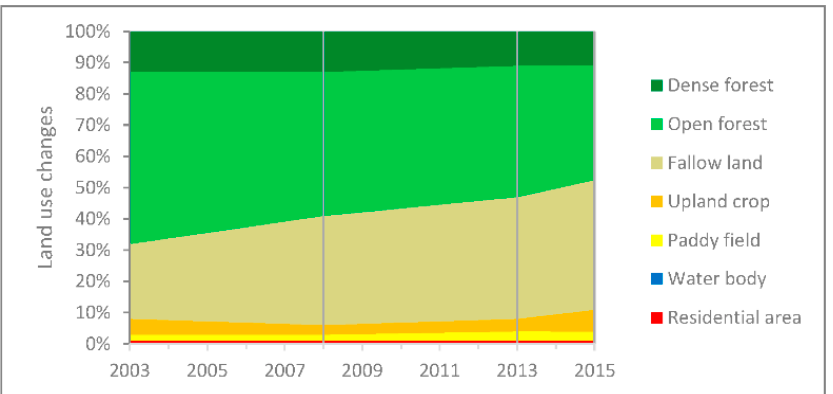
Figure 4. Land-use change in the Natong area, Xiengkhor District, Huaphan Province from 2003 to 2015.